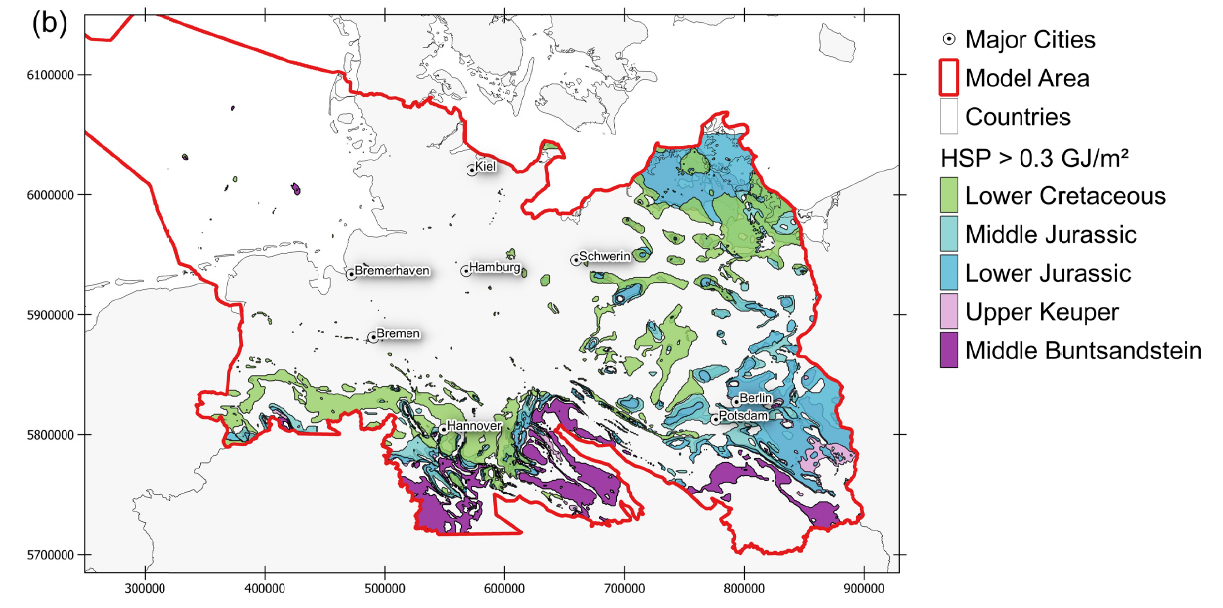
Figure 7. Areas of high geothermal potential in the North German Basin based on the temperatures from [32]: ( a ) Areas in the North German Basin with HIP larger than 1 GJ/m 2 for each of the studied stratigraphic units; ( b ) Areas in the North German Basin with HSP larger than 0.3 GJ/m 2 for each of the studied stratigraphic units; ( a , b ) Coordinates are in UTM Zone 32N. Color-coding after the youngest/shallowest encountered unit. Lower Cretaceous to Upper Keuper have 80% opacity to symbolize underlying reservoirs with high